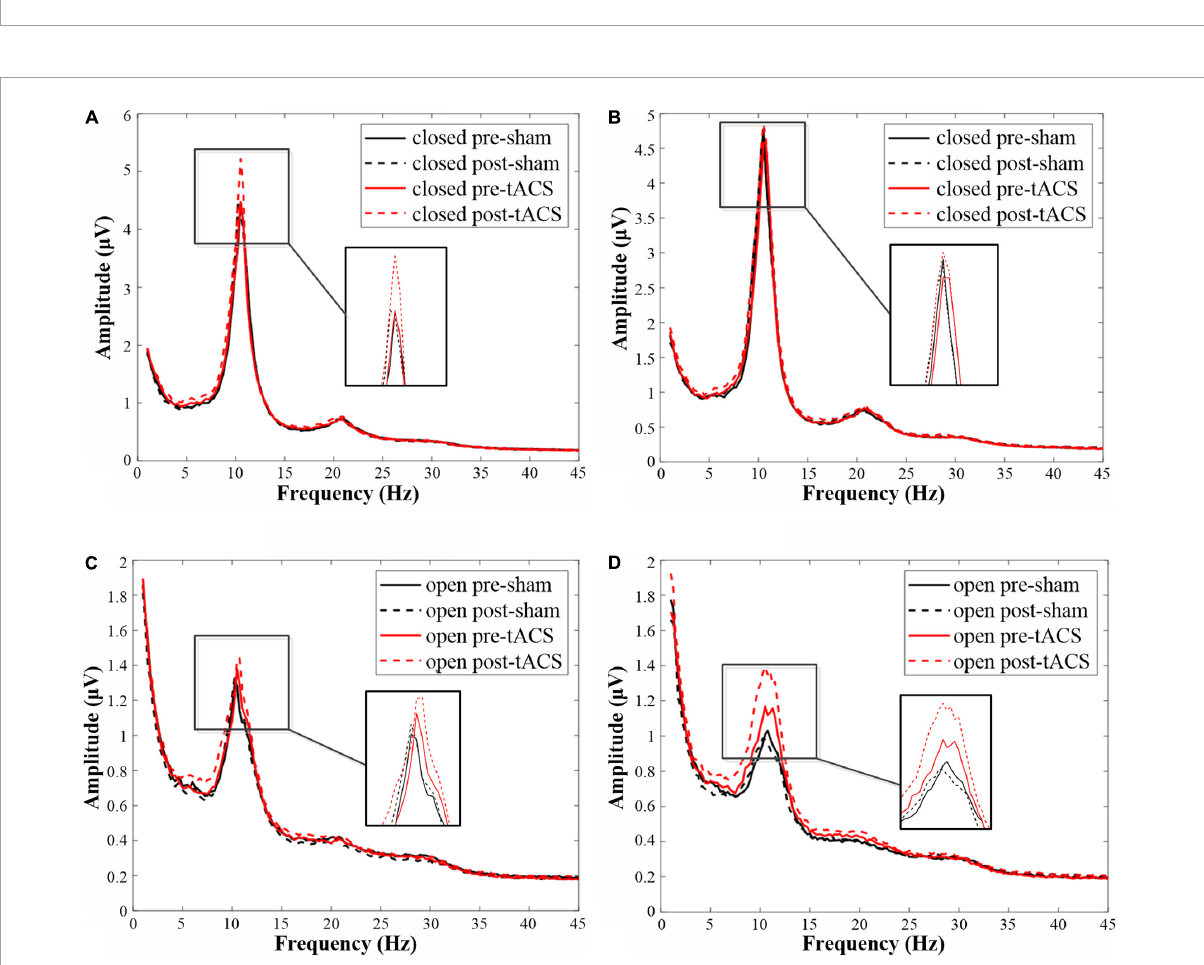
FIGURE6 The amplitude in the alpha frequency band under each condition within 10 subjects who participated in both low- and high-stimulus experiments. (A) The amplitude map of 1-mA stimulation in the eyes-closed state. (B) The amplitude map of 1-mA stimulation in the eyes-open state. (C) The amplitude map of 2-mA stimulation in the eyes-closed state. (D) The amplitude map of 2-mA stimulation in the eyes-open